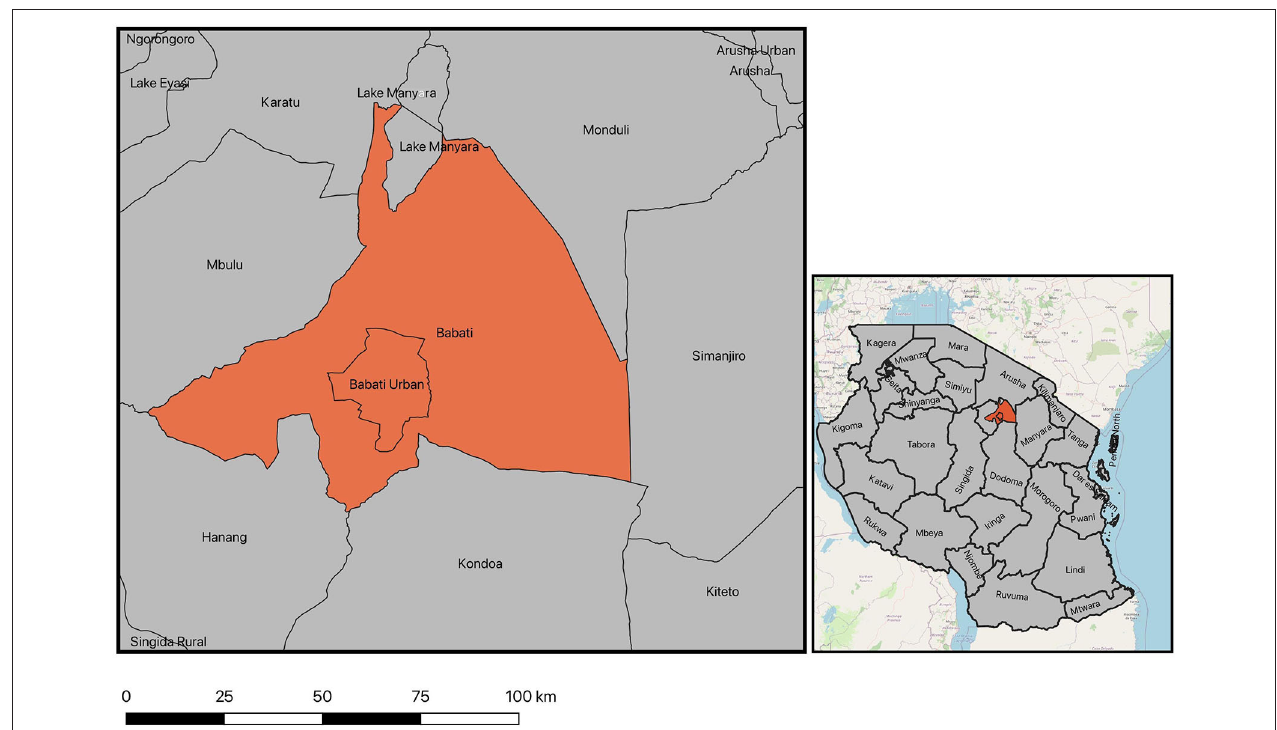
FIGURE 2 | Map of Babati district encompassing Msitu village. Source: (48).